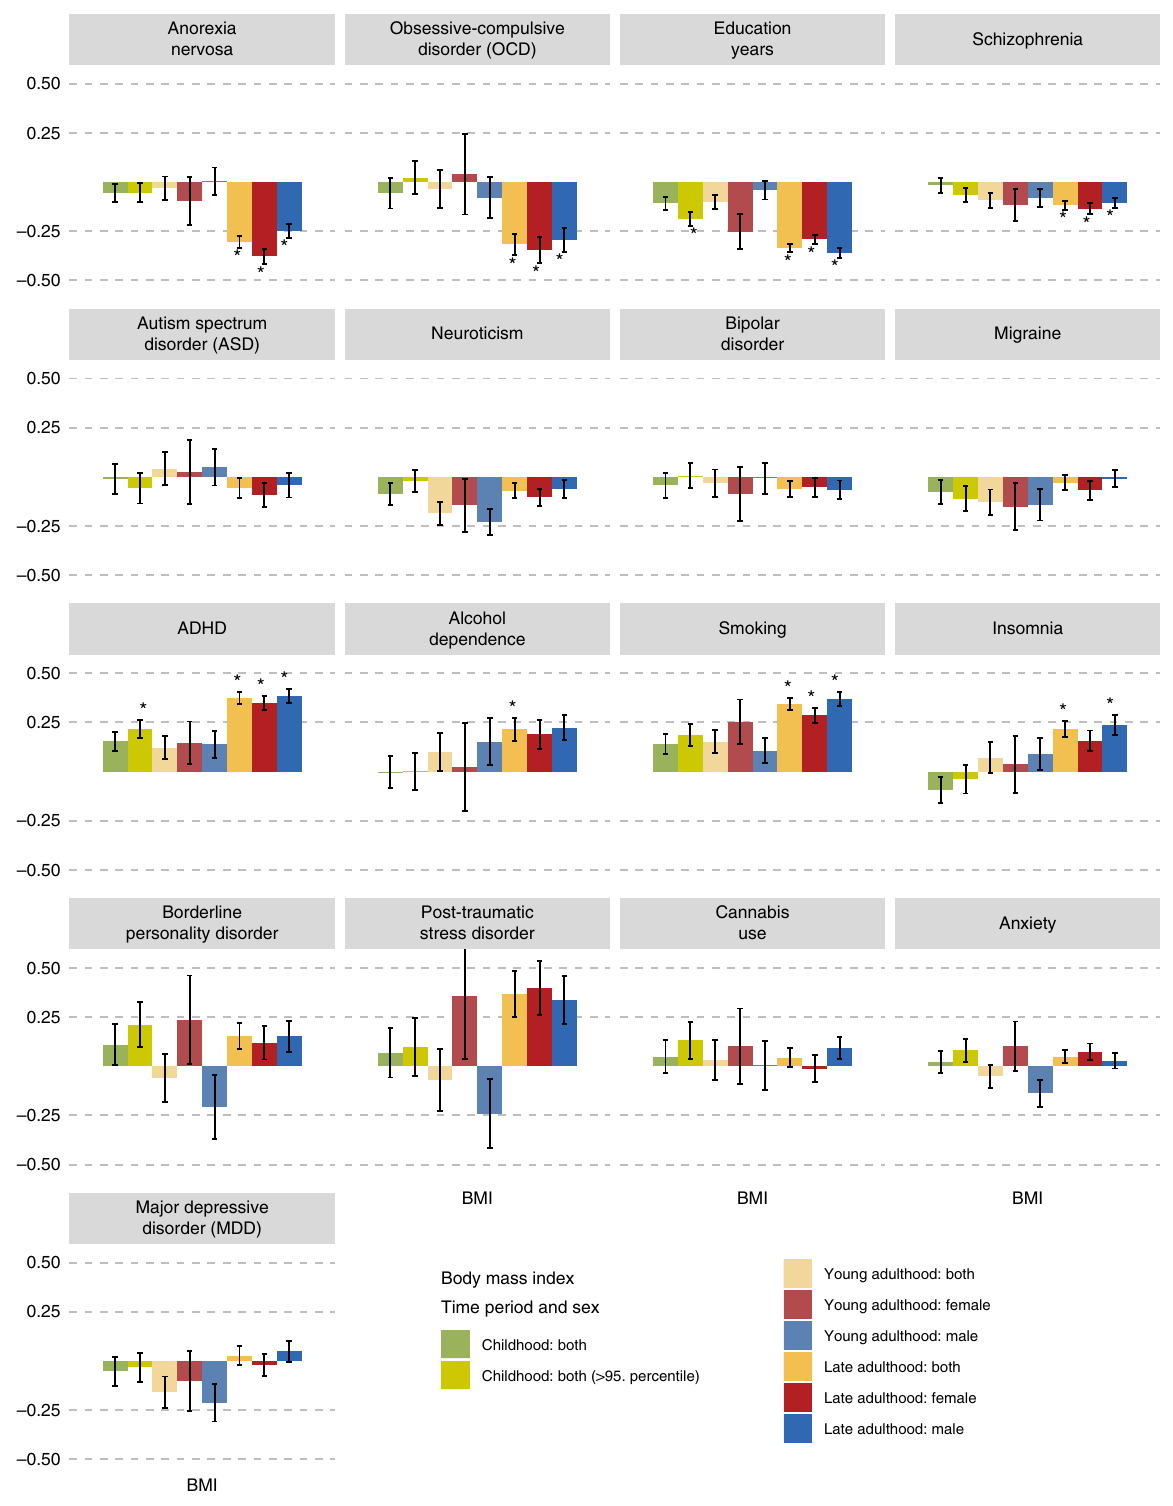
Fig. 4 Age-dependence of sex-speci fi c genetic correlations across body composition and psychiatric traits. Sex-speci fi c genetic correlations of body mass index (BMI) and fat-free mass ( n = up to 157,355) with psychiatric disorders ( n = up to 77,096) and behavioural traits ( n = up to 157,355) across the lifespan. Participants of the childhood BMI GWAS (green, n = 35,668) were younger than 10 years, the participants of the young adulthood GWASs (lighter colours, n = 29,054) were between 15 and 35 years, participants of the late adulthood GWAS (darker colours, n = 155,961) were between 39 – 75 years old. Overweight in childhood (lime green; n = 13,848) was included as an extreme phenotype. The autosomal genetic correlations were calculated by bivariate linkage disequilibrium score regression (LDSC). Coloured bars represent genetic correlations, error bars depict standard errors (s.e.) and asterisks indicate statistically signi fi cant genetic correlations with p values less than α = 0.0002. This threshold was calculated via the identi fi cation of the number of independent tests using matrix decomposition of the genetic correlation matrix and subsequent Bonferroni correction of α = 0.05 for 210 independent tests. ADHD = attention-de fi cit/hyperactivity